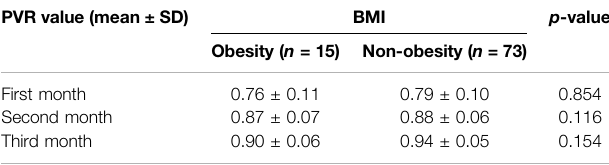
TABLE 4 | Subgroup analysis for the early PVR based on BMI.